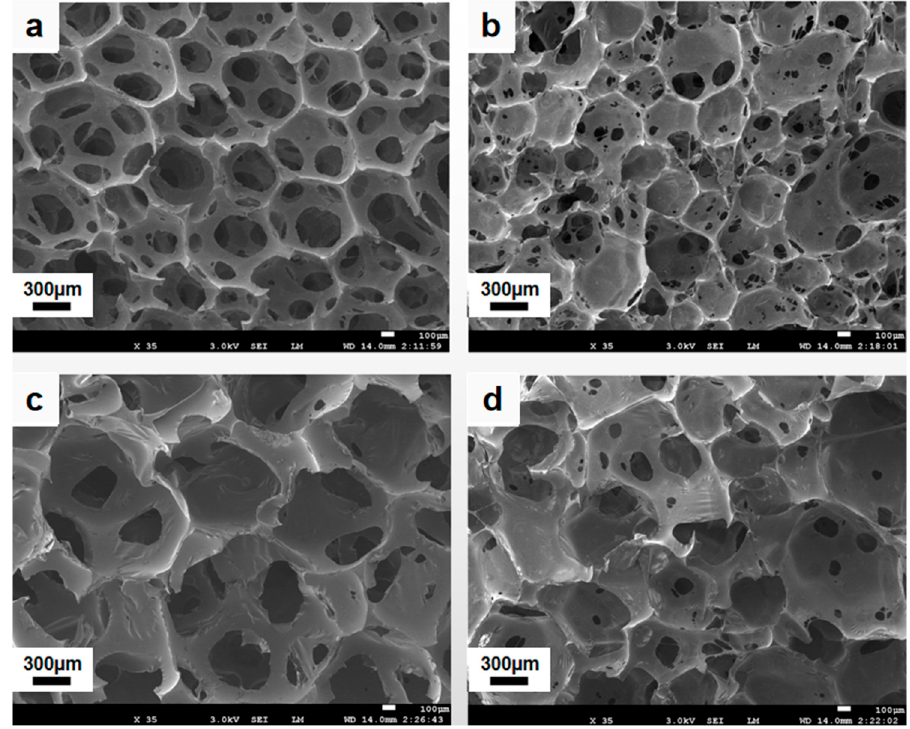
Figure 2. SEM images for cross-sections of pure FPUF ( a ), FPUF/10EG ( b ), FPUF/P ( c ), and P-FPUF/10 EG ( d ), ×35.